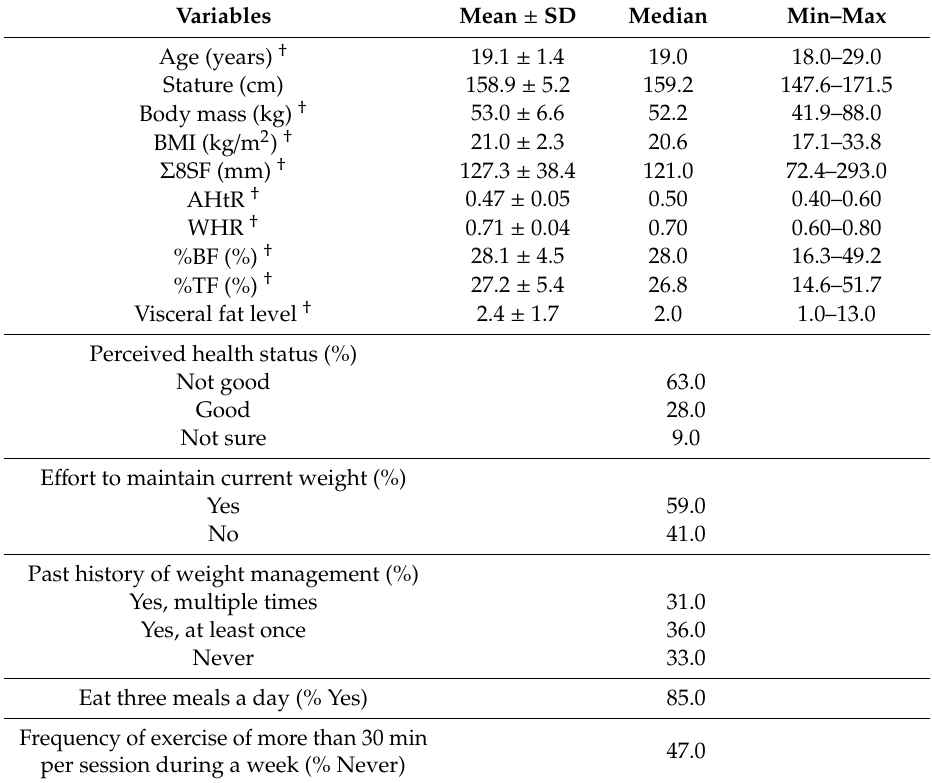
Table 1. Demographic characteristics of participants ( n = 100).